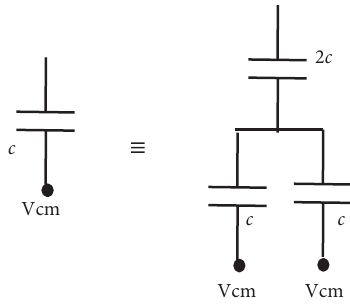
Figure 15: Te C-2C dummy capacitor.